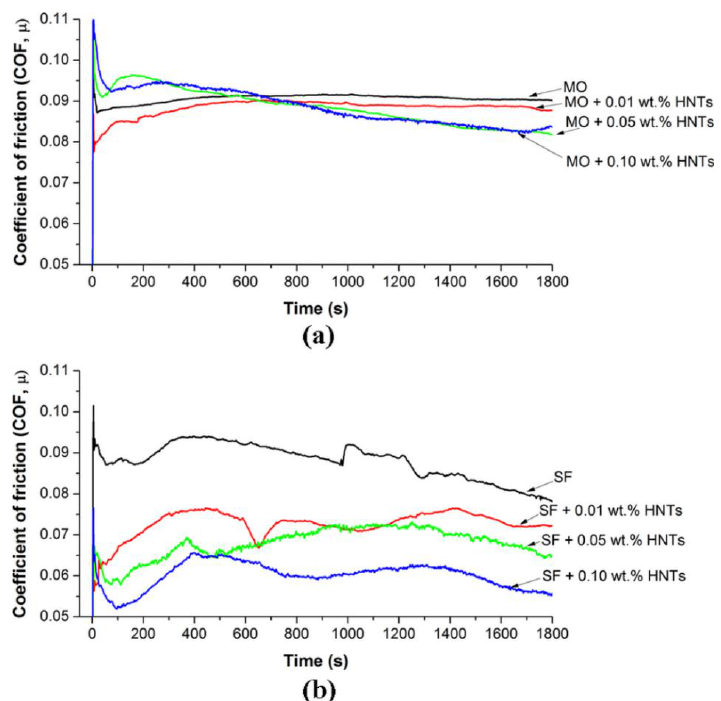
Figure 5. Coefficient of friction (COF) behavior as a function of time for: ( a ) MO + HNT nanofluids; ( b ) SF + HNT nanofluids.